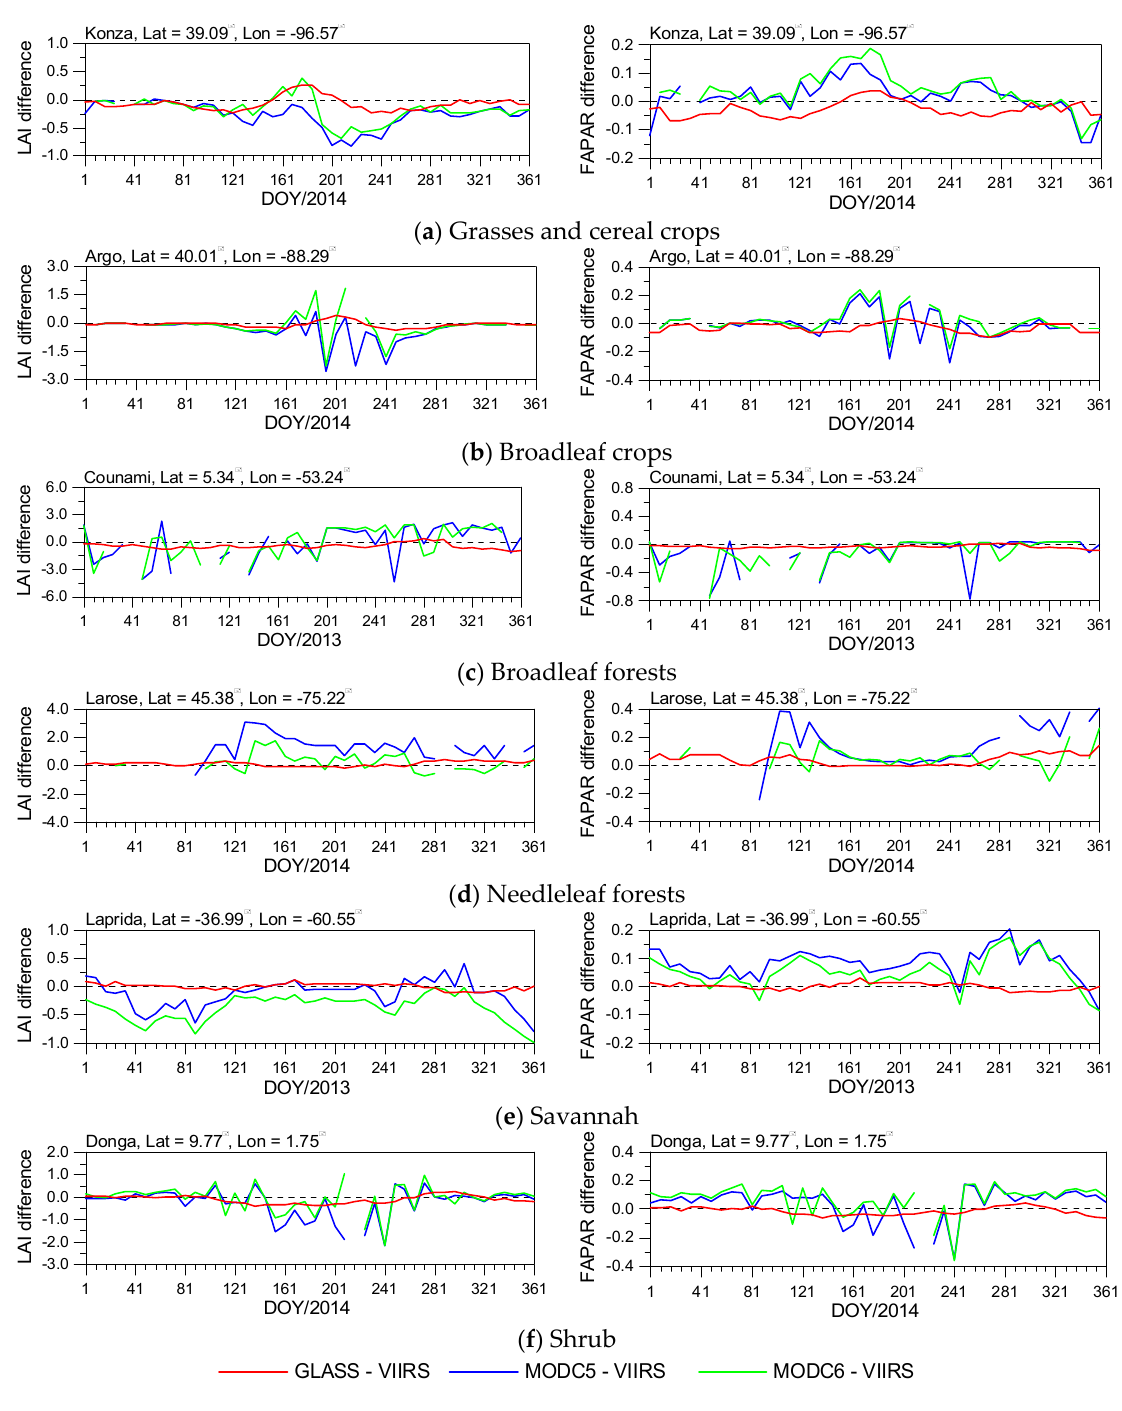
Figure 7. Temporal profiles of the differences between GLASS, MODC5, MODC6 LAI/FAPAR products and VIIRS LAI/FAPAR products at several sites with different vegetation types. The temporal profiles of LAI differences are shown in the left panel, and the temporal profiles of FAPAR differences are shown in the right panel. ( a ) Grasses and cereal crops; ( b ) Broadleaf crops; ( c ) Broadleaf forests; ( d ) Needleleaf forests; ( e ) Savannah; ( f ) Shrub.